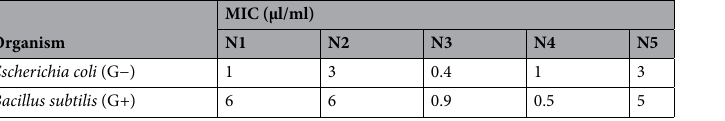
Table 3. Minimal inhibitory concentration (MIC, μl/ml) of acrylonitrile adducts against Gram negative and Gram positive bacteria.